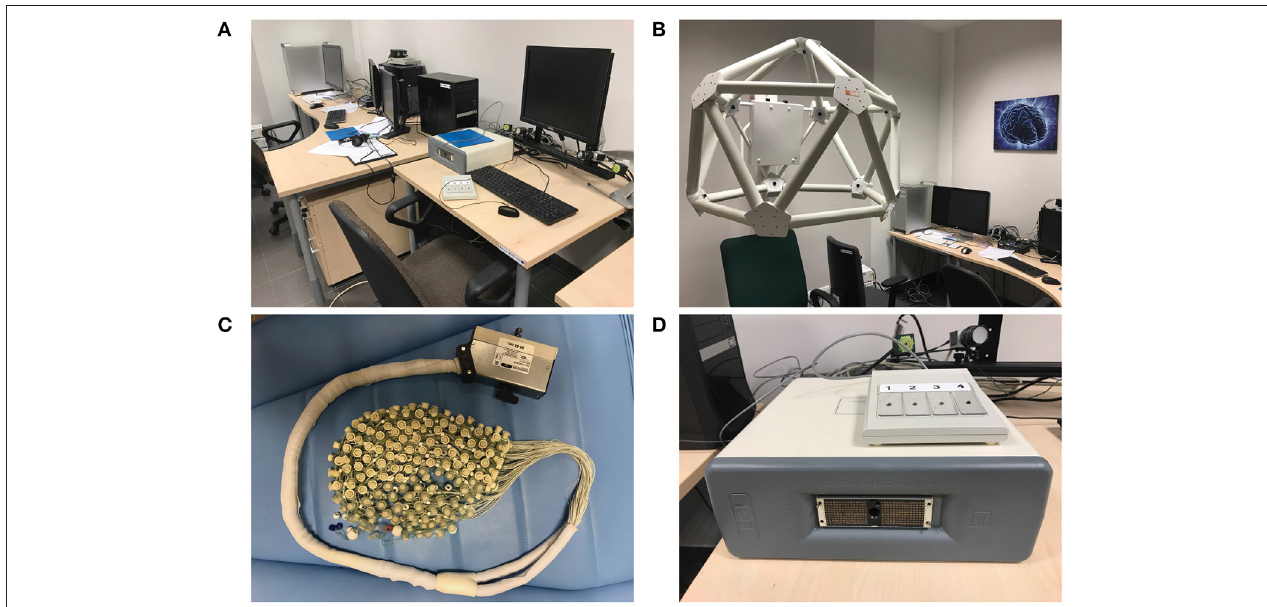
FIGURE 1 | EEG Laboratory in the Department of Neuroinfomatics. From the top-left corner clockwise: (A) general lab view, (B) GPS photogrammetry station, (D) 256-channel dense array amplifier with response pad, (C) Geodesic Sensor Net with 256